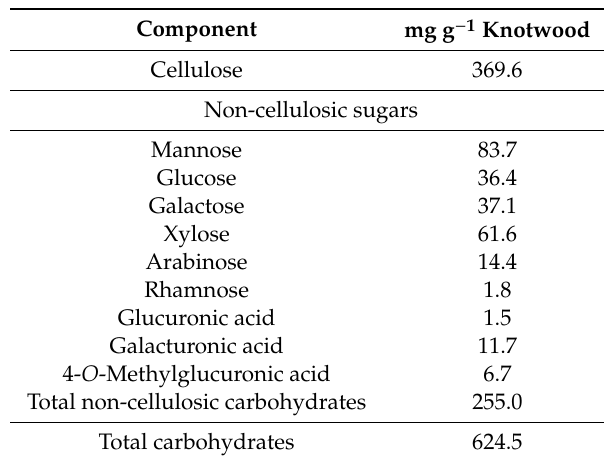
Table 1. Carbohydrates’ composition of the knotwood as